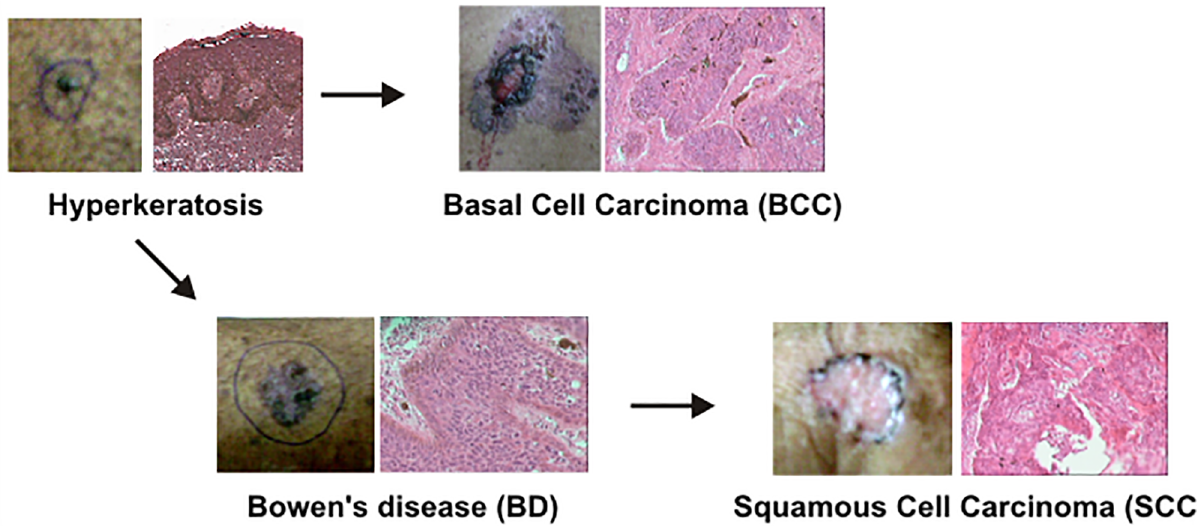
Fig 1. Arsenic-induced skin cancer progression. Progression from the premalignant hyperkeratosis lesion (HK) to either of the malignant lesions, basal cell carcinoma (BCC) directly or squamous cell carcinoma (SCC) through Bowen’s disease (BD, SCC in situ ). Shown are photographs of lesions in situ prior to excision with a histological section of the formalin fixed and paraffin embedded sample stained with hematoxylin and eosin on the right.